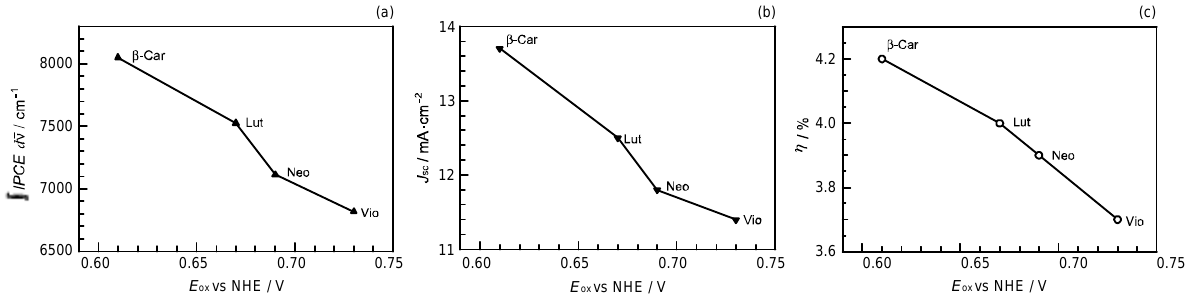
Figure 26. Dependence of ( a) the integrated IPCE ( ∫ IPCE d v ), (b) photocurrent ( J (c) conversion efficiency ( η ) of Phe a -sensitized solar cells on the one-electron oxidation ) of the Car spacer (reprinted from [18], Copyright (2006), with permission potential ( E ox from